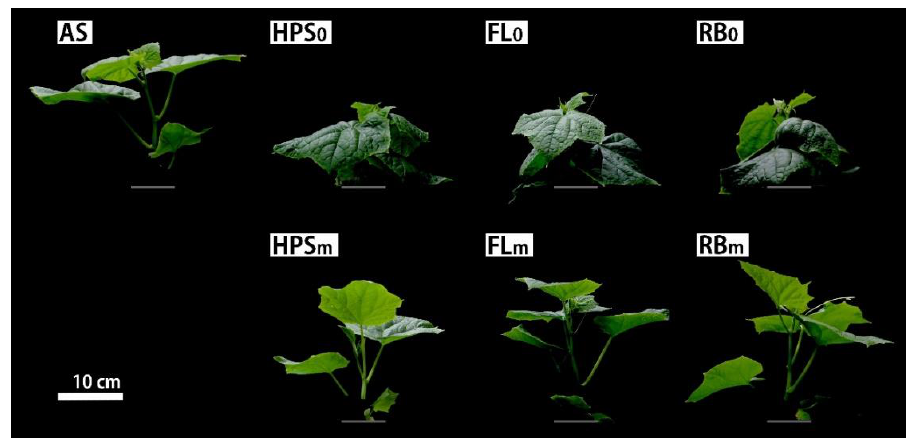
Figure 4. Photomorphogenesis of representative cucumber plants in each treatment at 21 days after transplanting. Grey bars indicate the ground level. See 2.4 for treatments.